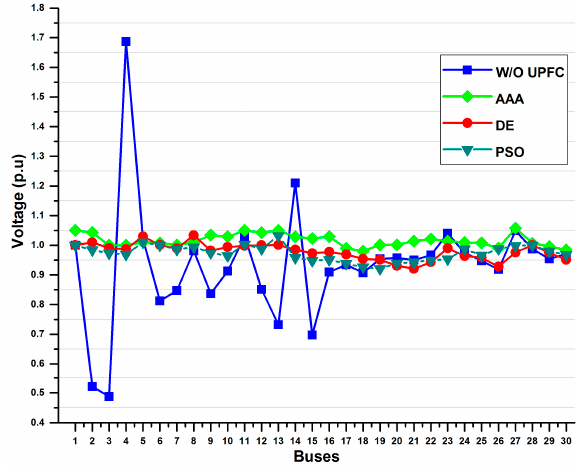
Figure 7. Voltage magnitudes for Case Study-2 by AAA, D.E and PSO when line 1 is trip.